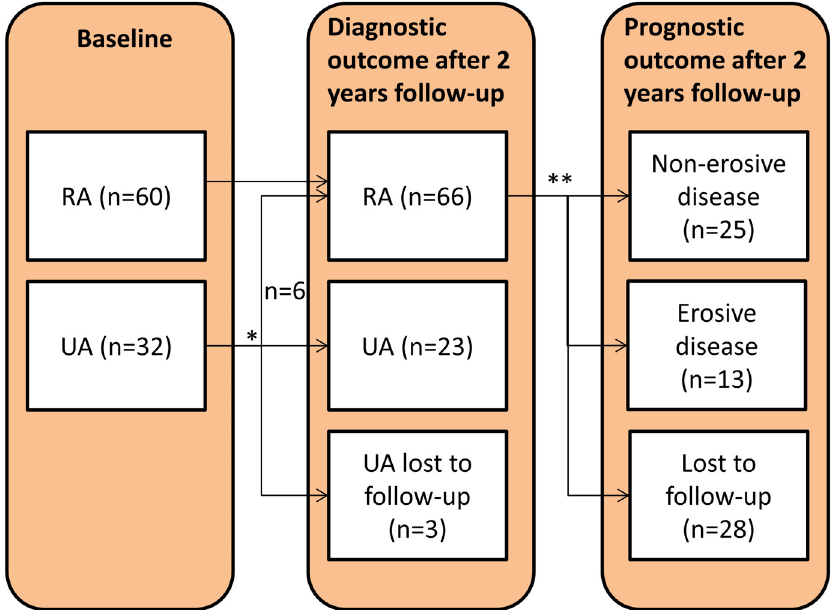
Fig 1. Schematic overview of the study. At baseline the selected patients either fulfilled the ACR/EULAR 2010 criteria for the classification of rheumatoid arthritis (RA; n = 60) or had unclassified arthritis (UA; n = 32). Patients were followed for 2 years and those with UA were categorized as having either converted to RA (UA-RA; n = 6) or remained unclassified (UA-UA; n = 23). Patients fulfilling the ACR/EULAR 2010 criteria for RA after the 2 years follow-up were further classified for arthritis outcome into non-erosive disease (n = 25) or erosive disease (n = 13). * Three patients were not available for follow-up and were therefore excluded from the diagnostic outcome analysis. ** Of 28 patients the arthritis outcome data were not available and were therefore excluded from the prognostic outcome analysis.